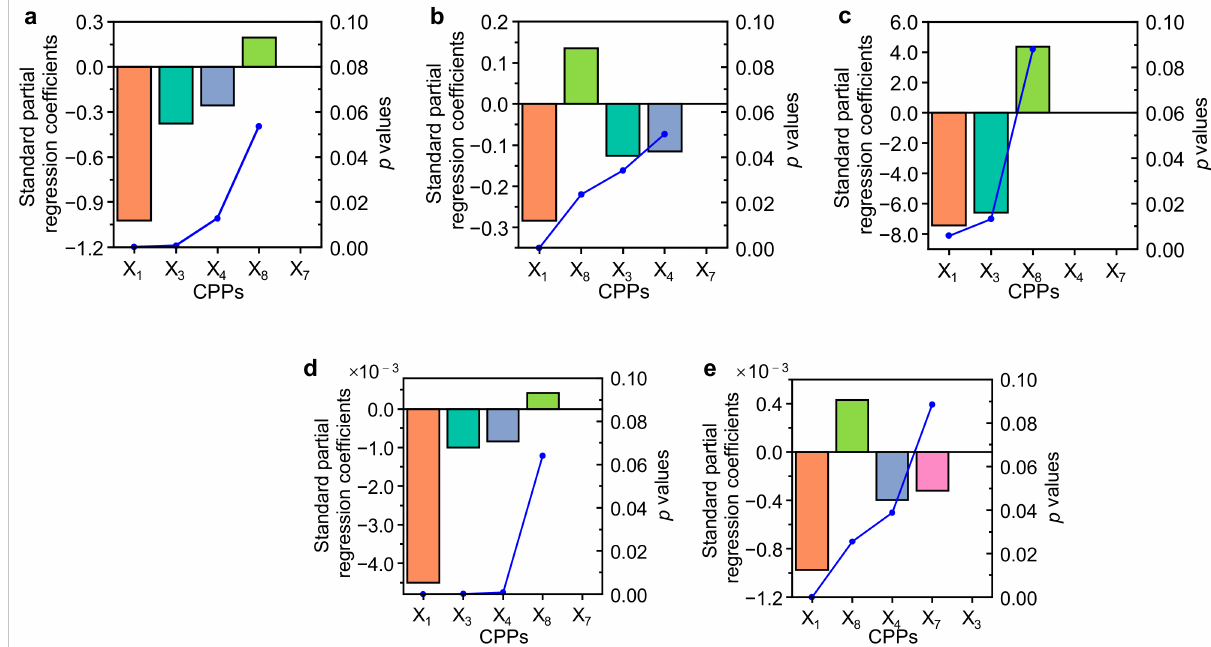
Figure 4. The standard partial regression coefficients and p values of the multiple linear regression model. Blue dotted lines are p values; columns represent standard partial regression coefficients. ( a ) HSYA extracted amount; ( b ) total flavonoids extracted amount; ( c ) total solids extracted amount; ( d ) HSYA purity; ( e ) total flavonoid purity; X 1 : density of the concentrated extract; X 3 : ethanol concentration; X 4 : ECR; X 7 : stirring time after ethanol addition; X 8 : refrigeration